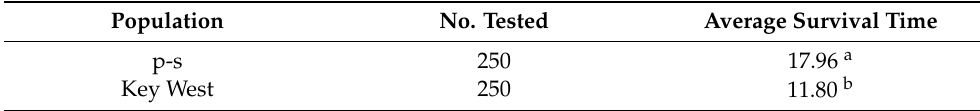
Table 4. Analysis of survivorship of the Ae. aegypti populations. Population No. Tested